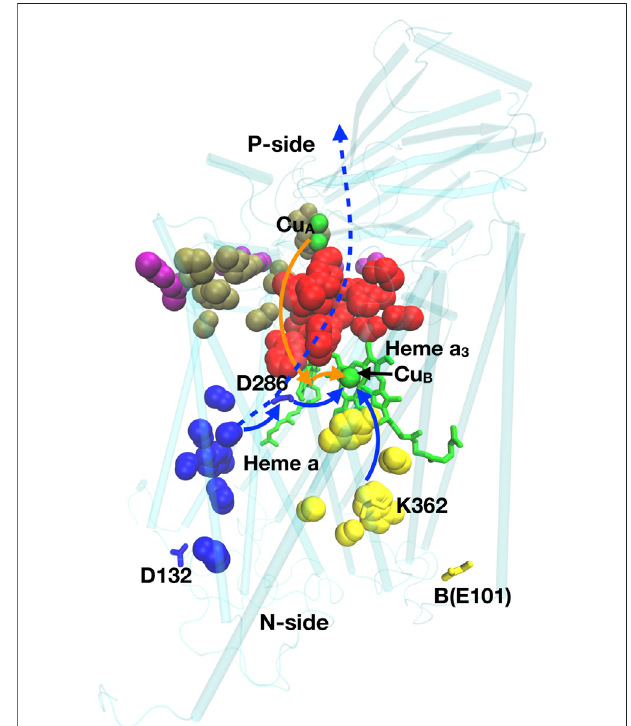
FIGURE 9 | Residues of importance for proton pumping in CcO. Residues D132, K362, D286, B(E101) are shown; heme a and a 3 are green sticks;Cu A and Cu B , aregreenspheres.Blue spheres: D-channel; red: P-side cluster PLS; yellow: K-channel; Brown: P-exit path; Purple: P-exit surfacecluster.Solidbluelines:pathofprotonsused forchemistryintheBNC (heme a 2 and Cu B ), dashed blue line: path for pumped protons; orange line: electron transfer path. Structure of Rb. sphaeroides CcO from PDB